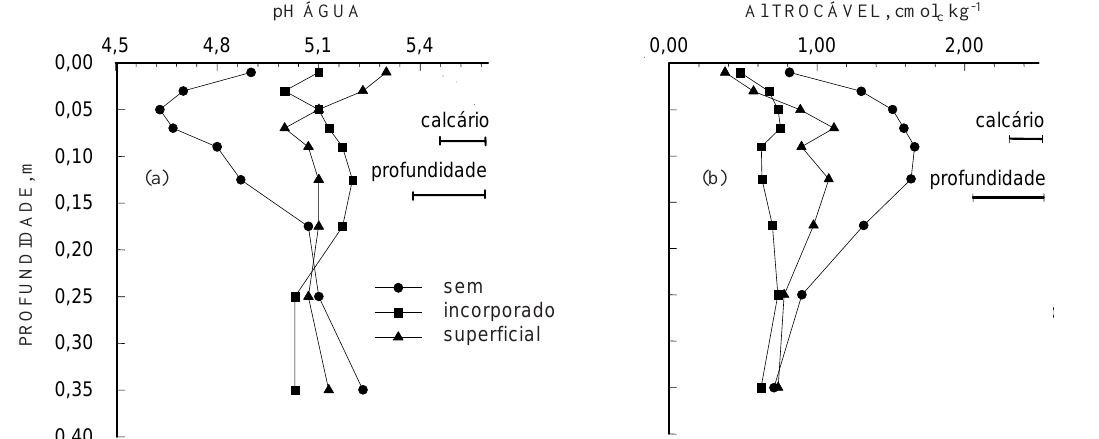
Figura 1. Valores de pH em água (a) e teores de Al trocável (b) de um Latossolo Bruno alumínico em plantio direto, considerando três tratamentos de calagem (sem calcário, calcário incorporado e calcário superficial). Barras horizontais representam a diferença mínima significativa pelo teste de Tukey a 5 % (calcário = método de aplicação de calcário, profundidade = profundidade amostrada do